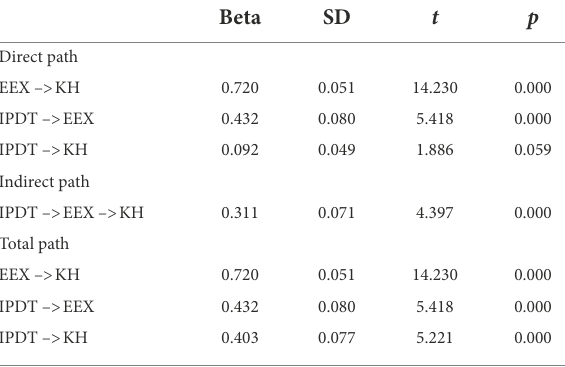
TABLE 4 Direct, indirect and total path estimates (mediation).